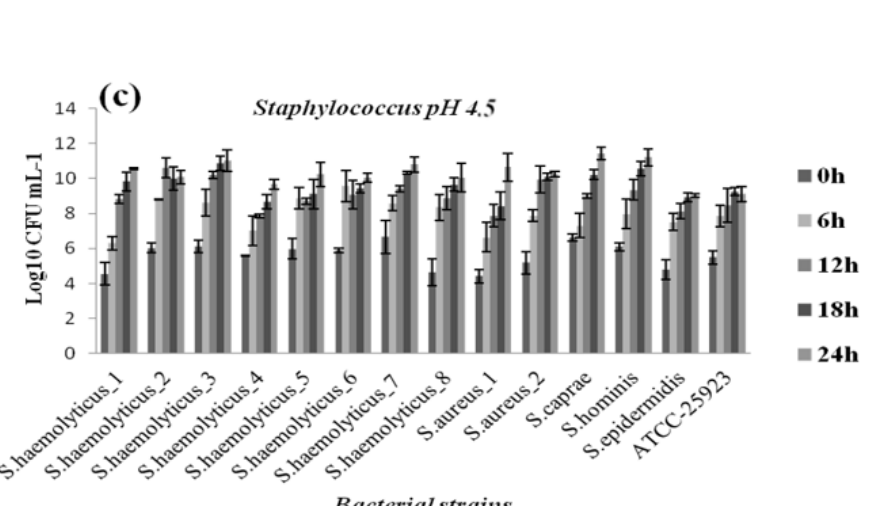
Figure 6. Growth of vaginal staphylococcus strains at pH 3.5 ( a ); pH 4 ( b ); and pH 4.5 ( c ).